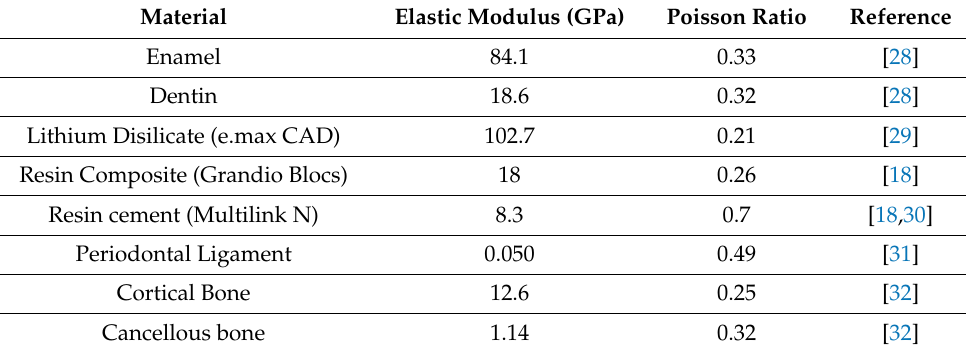
Table 1. Materials properties considered in the present